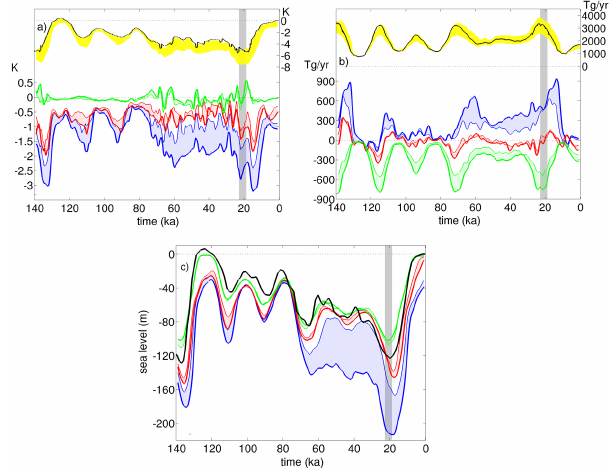
Figure 8. Response to dust DRF from simulation experiments for last 140kyr. (a) Global SAT (K) of control simulation mi- nus present-day SAT (black line) and range from upper and lower SAT (yellow shaded) from simulations with solution L1 and RI = 0 . 0005 and 0 . 0060, and lower graphs show SAT anomaly series (K) from six simulation experiments minus control SAT series for RI = 0 . 0005, 0 . 0015 and 0 . 0060 (colour shading and line width as in Fig. 5). (b) Total dust emission flux (Tgyr − 1 ) of control simu- lation (black line) and range from upper and lower emission fluxes (yellow shaded) as in (a) , and lower graphs show dust emission flux anomalies (Tgyr − 1 ) as in (a) . (c) Sea level (m) from simulations (colour shading and line width as in (a) compared to data (black line) of Waelbroeck et al. (2002). Vertical grey bars as in Fig.